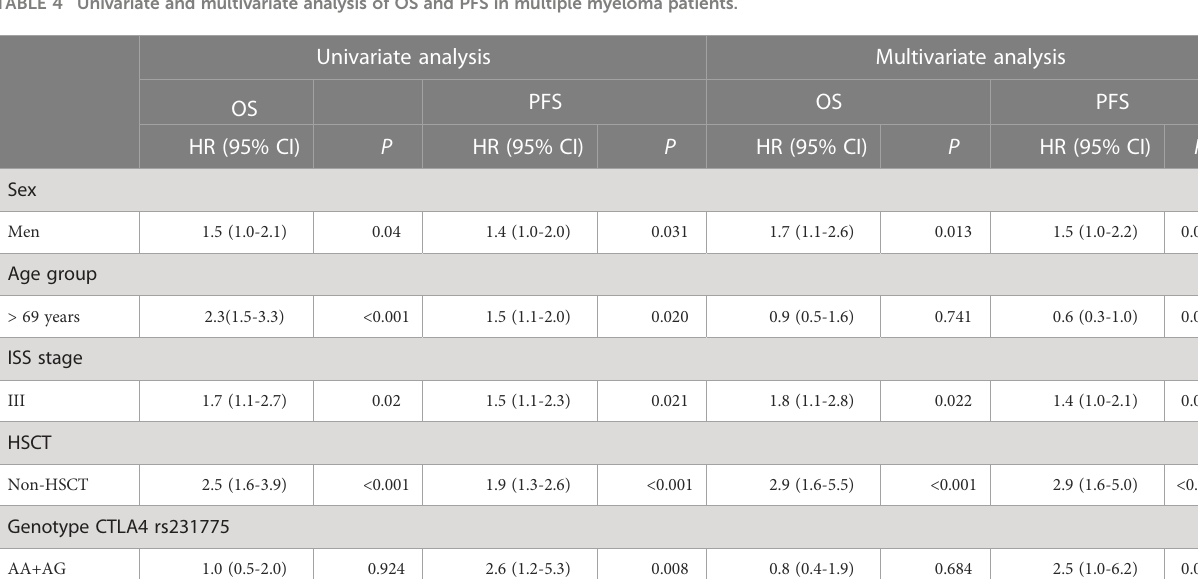
TABLE 4 Univariate and multivariate analysis of OS and PFS in multiple myeloma